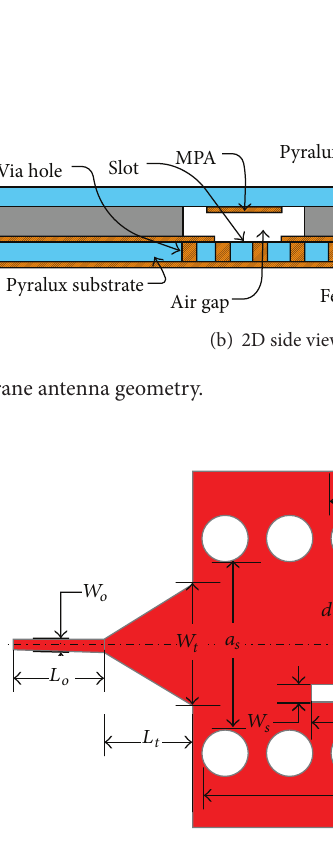
Figure 2: Top view of SIW antenna along with rectangular